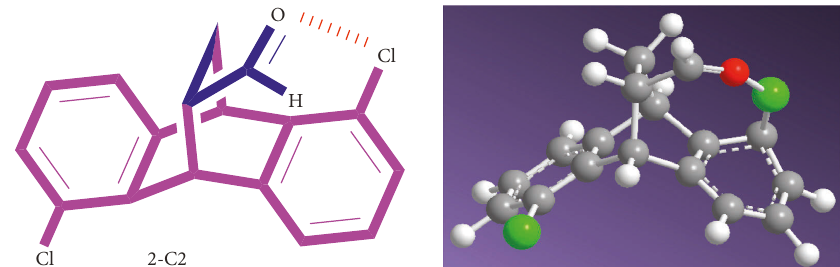
Figure 4: Plausible intramolecular interaction between chlorine (Cl) and oxygen (O) in 2-C2.